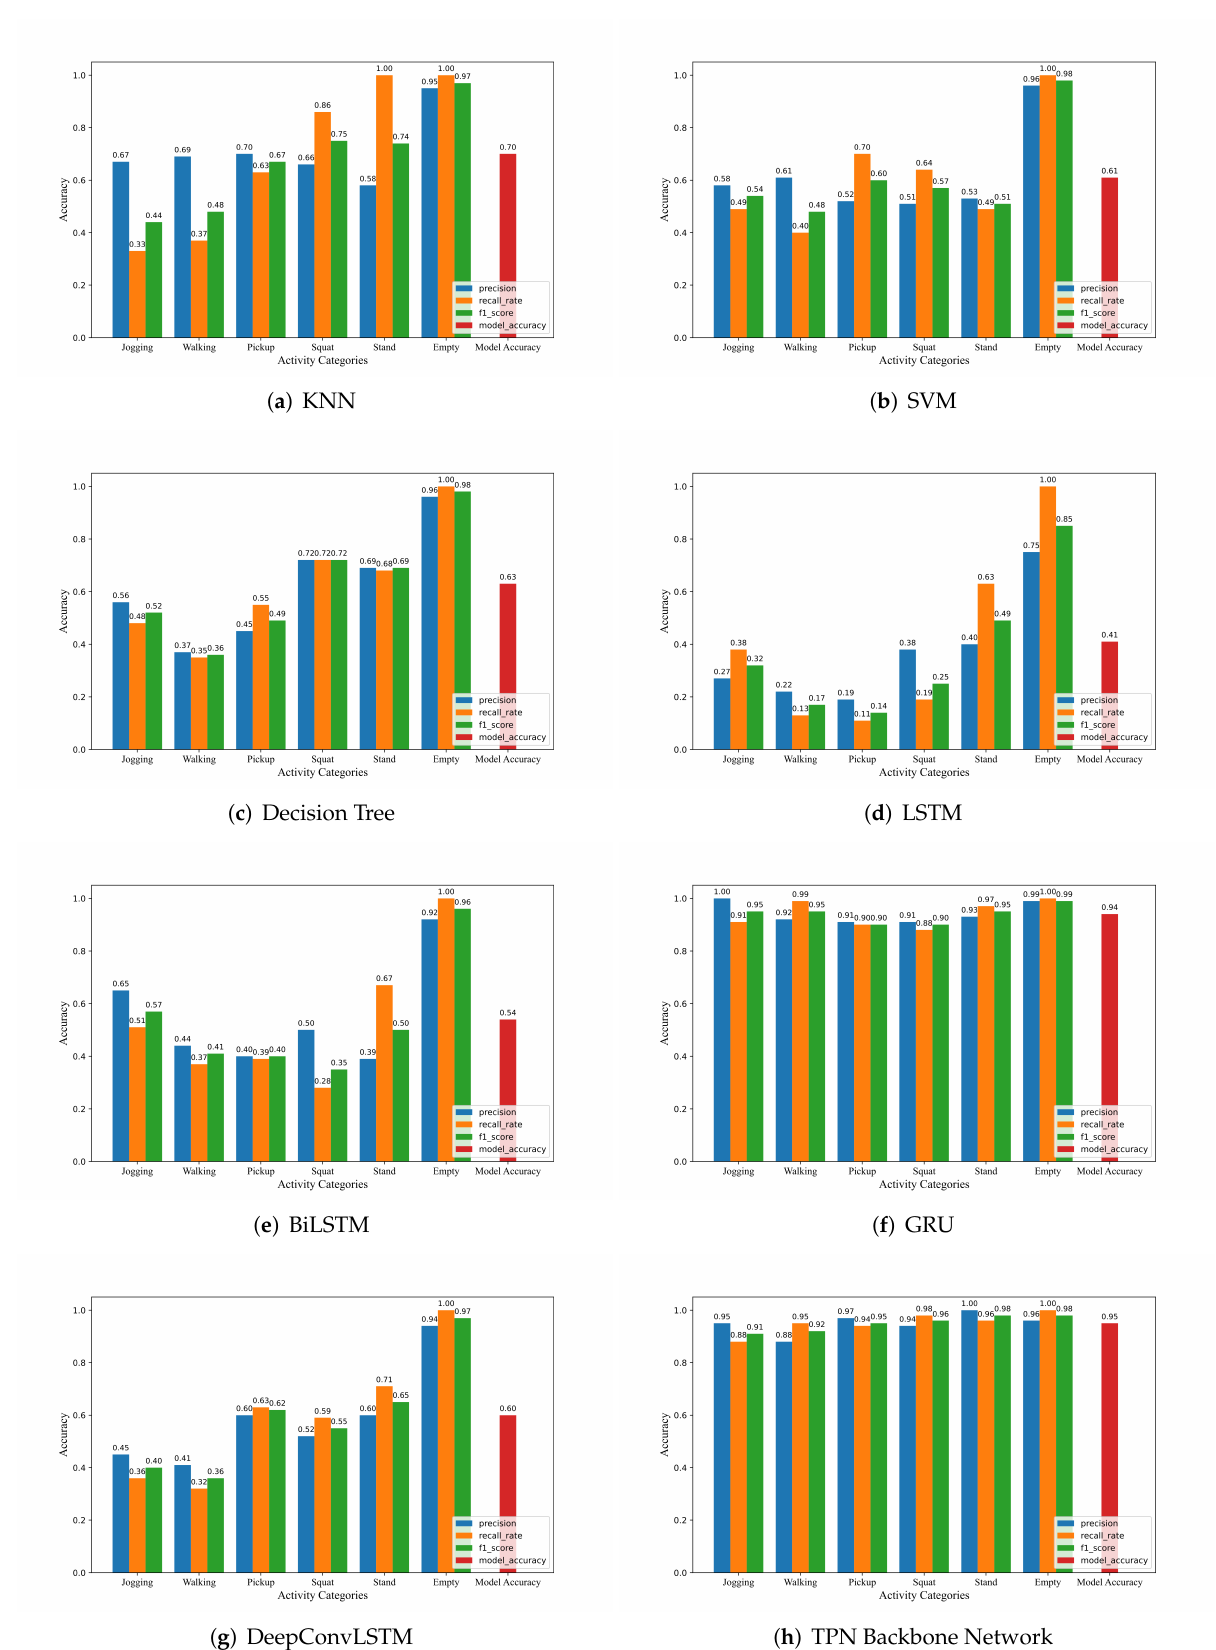
Figure 15. Main metrics of the experimental